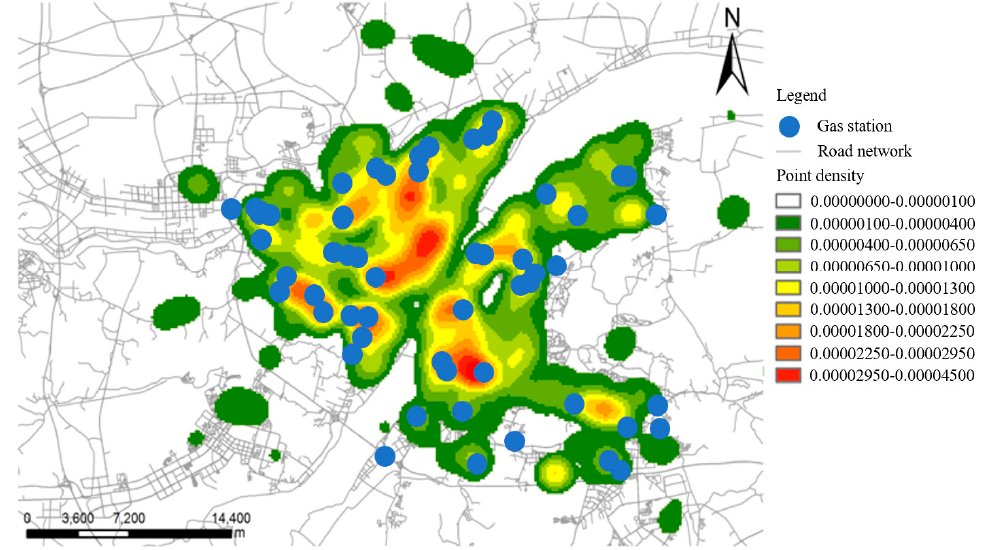
Figure 9. Spatial distribution of parking locations for taxi-driver shift events that occurred 1–7 August 2013.